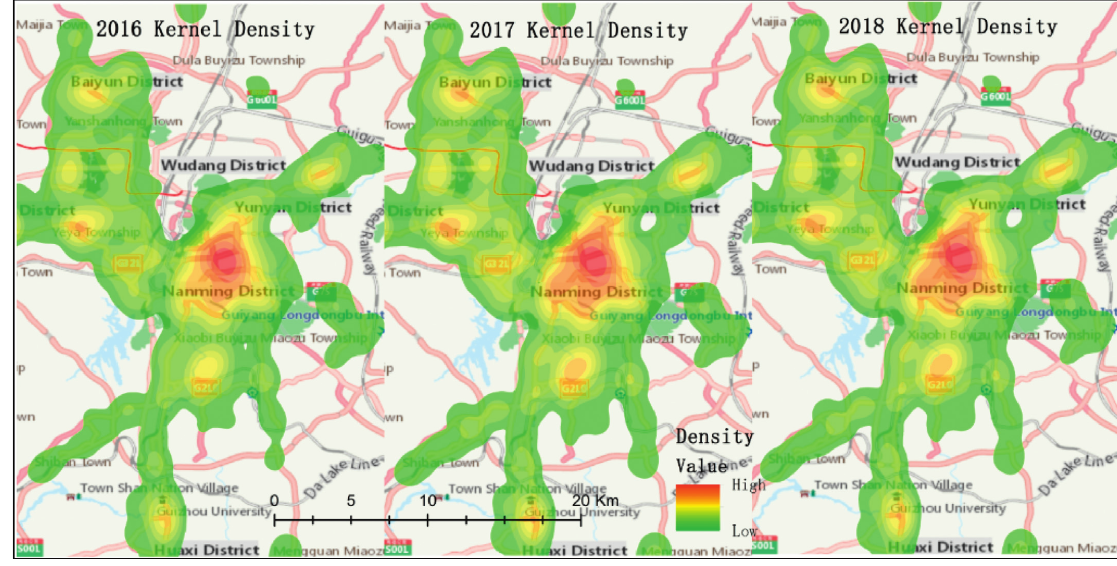
Figure 2: POI nuclear density from 2016 to